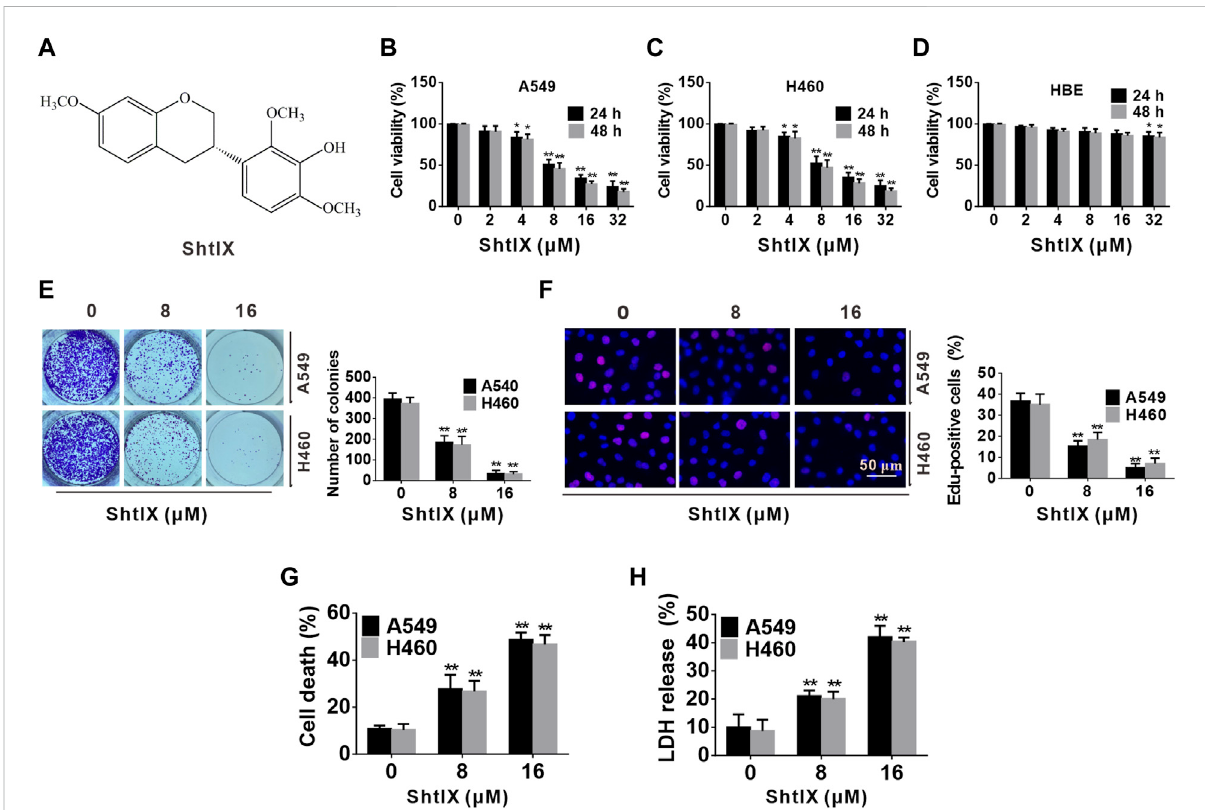
FIGURE 1 ShtIX inhibits cell proliferation and causes cell death in NSCLC cells. (A) The molecular structure of ShtIX. (B,C) Cell viability was measured by CCK-8 assay after cells were exposed to indicate concentrations of ShtIX at different times. (D) The viability of normal lung epithelial HBE cells was determined by CCK-8 assay. (E) The ability of cells to form colonies was observed after cells treated with indicated dose of ShtIX. (F) Cells proliferation was detected by EdU assay. (G,H) The NSCLC cell death was analyzed by trypan blue exclusion and LDH release assay. Data were presented as the mean ± SD of 3 independent experiments. * p < 0.05, ** p <